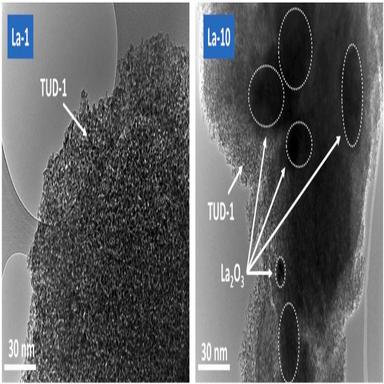
HR-TEM micrographs of the prepared La-1 and La-10 samples.